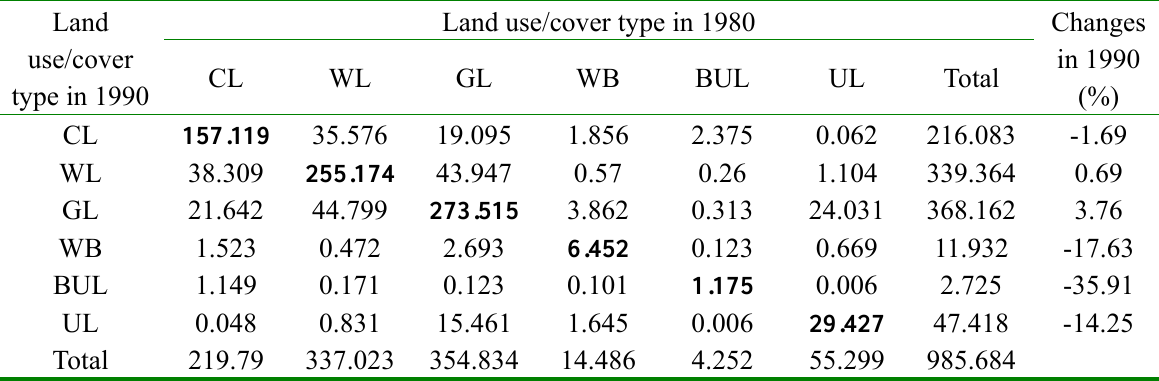
Table 1 . Transition matrix of each land use type in 1980 and 1990, and its change in 1990 (10 3 km 2 ).